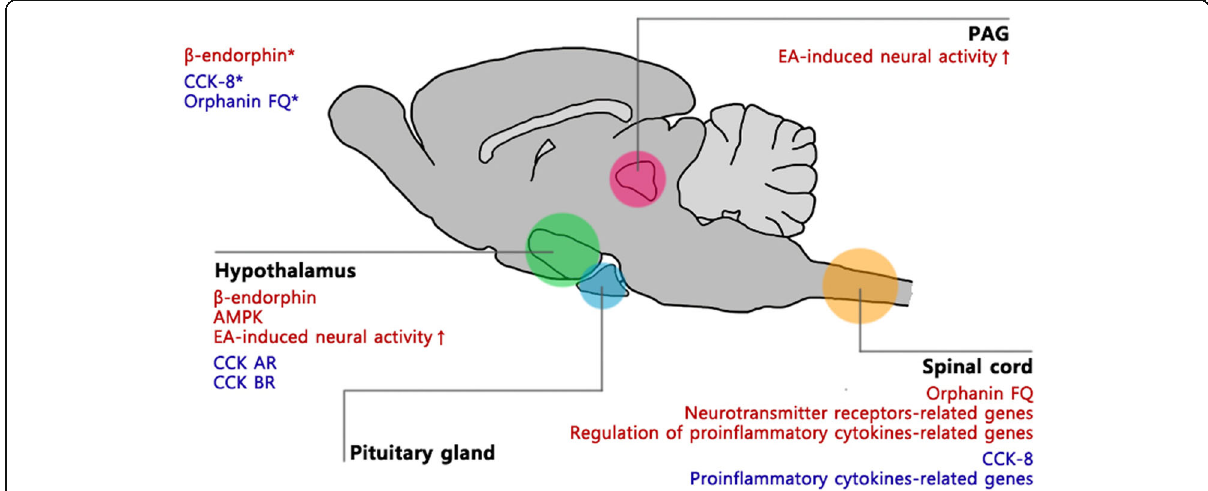
Fig. 2 A scheme of EA responsiveness-related factors and regions. The indicated specific regions, hypothalamus, PAG, pituitary gland and spinal cord, are well-known to be associated with pain regulation, and have been reconfirmed through researches on EA responsiveness. An asterisk implies intracerebroventricular injection. Responder-related factors and non-responder-related factors have been grouped in red and blue letters respectively. CCK AR, cholecystokinin A receptor; CCK BR, cholecystokinin B receptor; CCK-8, cholecystokinin octapeptide; Hypo, hypothalamus; PAG, periaqueductal grey; Pit. g., pituitary